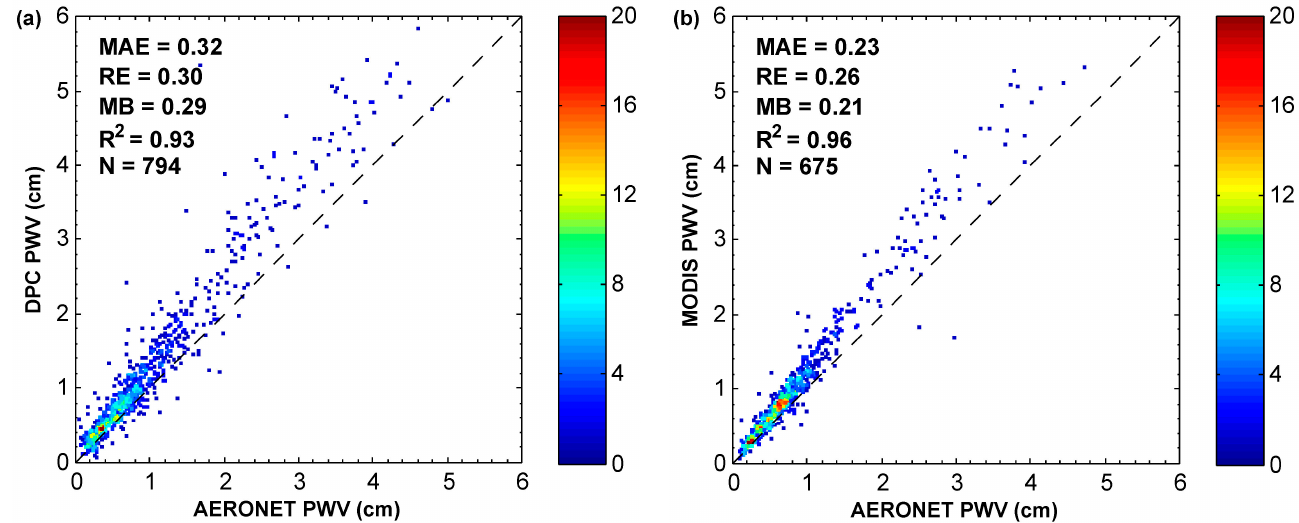
Figure 6. Validation results of satellite PWV data based on AERONET PWV data: ( a ) validation results of DPC PWV data; ( b ) validation results of MODIS PWV data. The color of each point denotes the number density at its location. The dotted line is the 1:1 line.